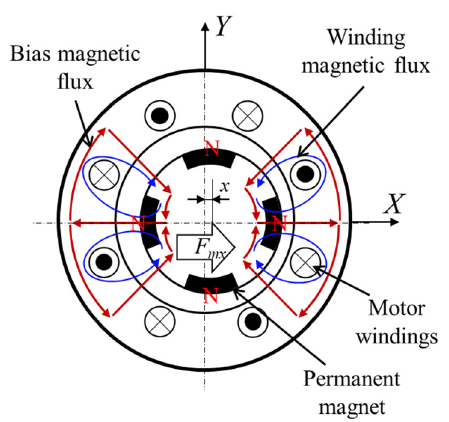
Figure 1. The magnetic flux flow of a PM motor with eccentricity in the X -direction.